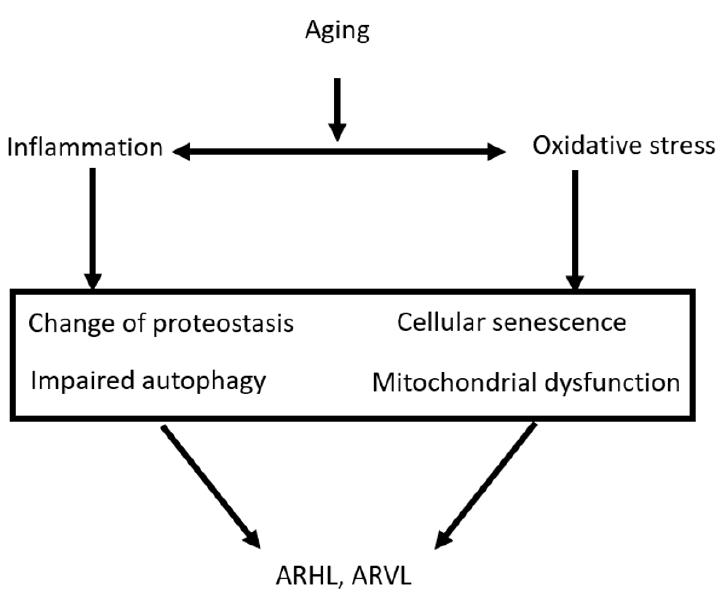
Figure 2. Pathogenetic mechanisms linked to ARHL and ARVL Summary of the pathogenetic mecha- nisms of age related hearing loss and vestibular loss. Aging contributes to inflammation and accumula- tion of oxidative stress which result in change of proteostasis, cellular senescence, impaired autophagy, and mitochondrial dysfunction. Ultimately, the inner ear is damaged by the detrimental substances.